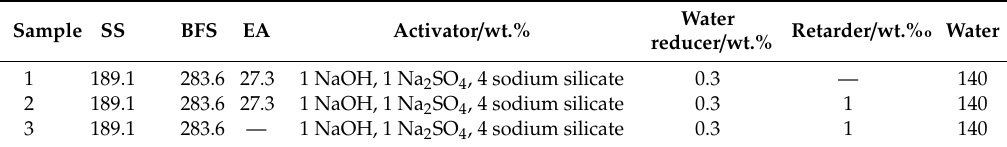
Table 6. The mix proportion of cementitious materials (kg / m 3 ).